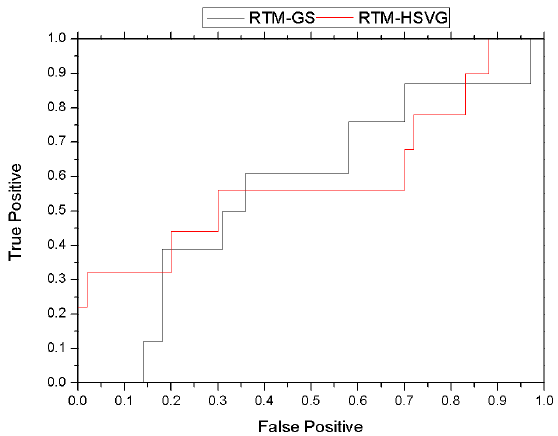
Figure 14. Comparative results of ROC on real video.